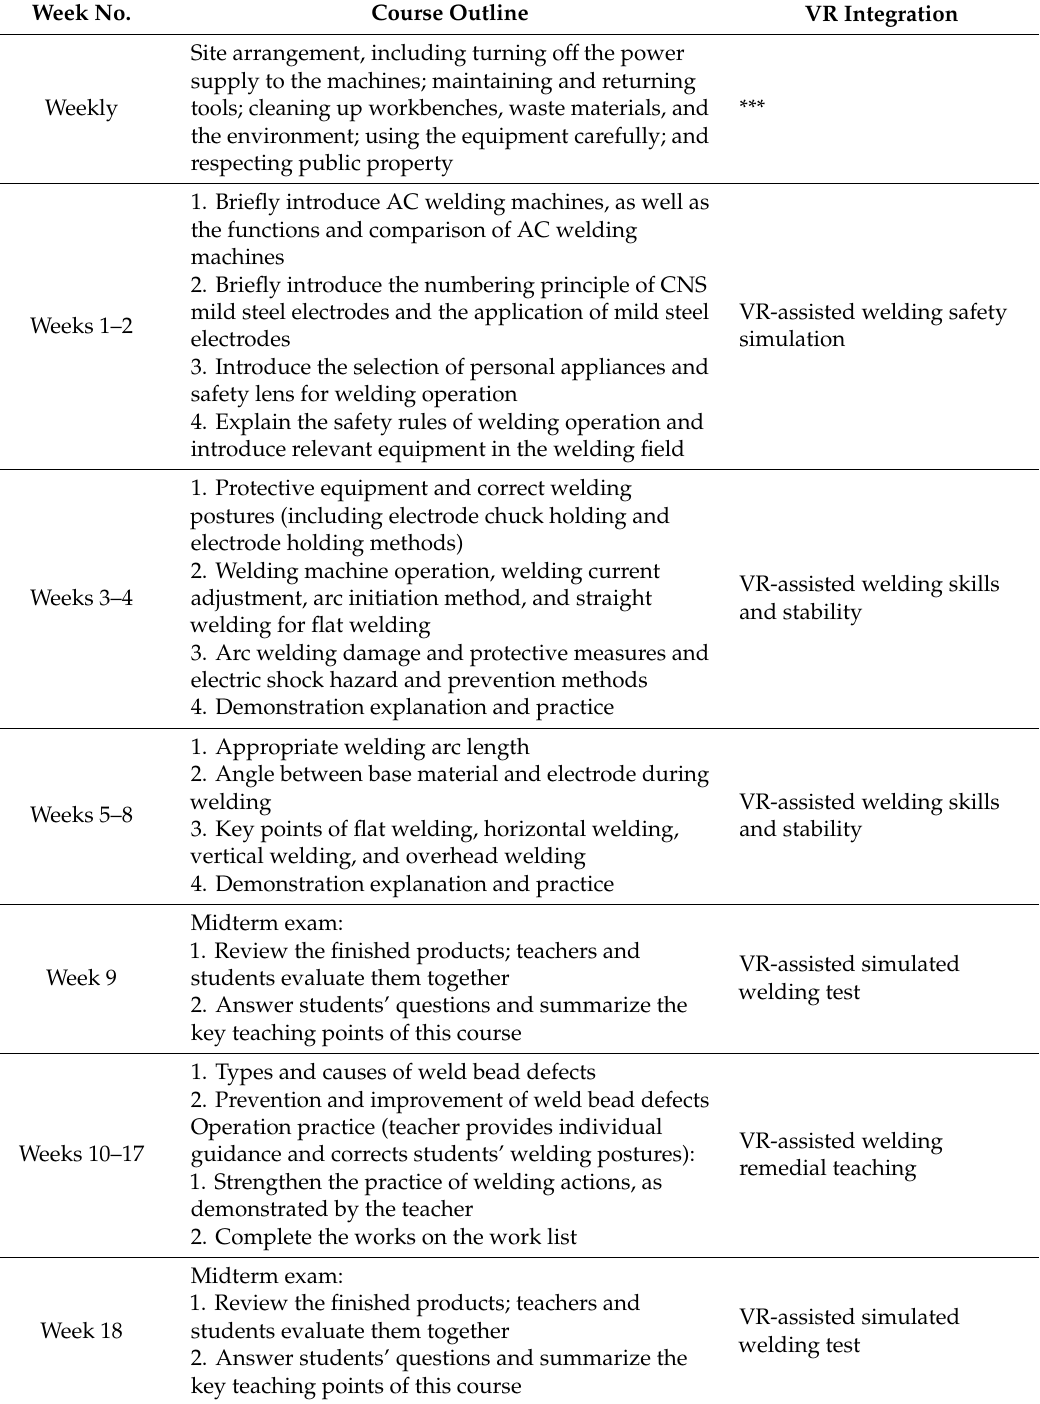
Table 7. VR Welding Course